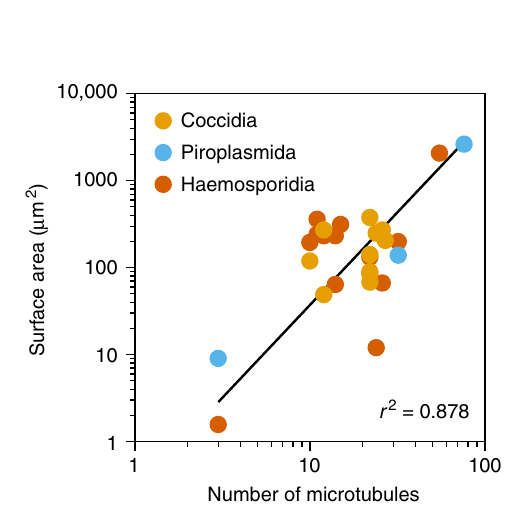
Fig. 6 The number of cortical microtubules is correlated to parasite size. Analysis of the number of cortical microtubules and surface area of various apicomplexan species and life cycle stages from the published literature.